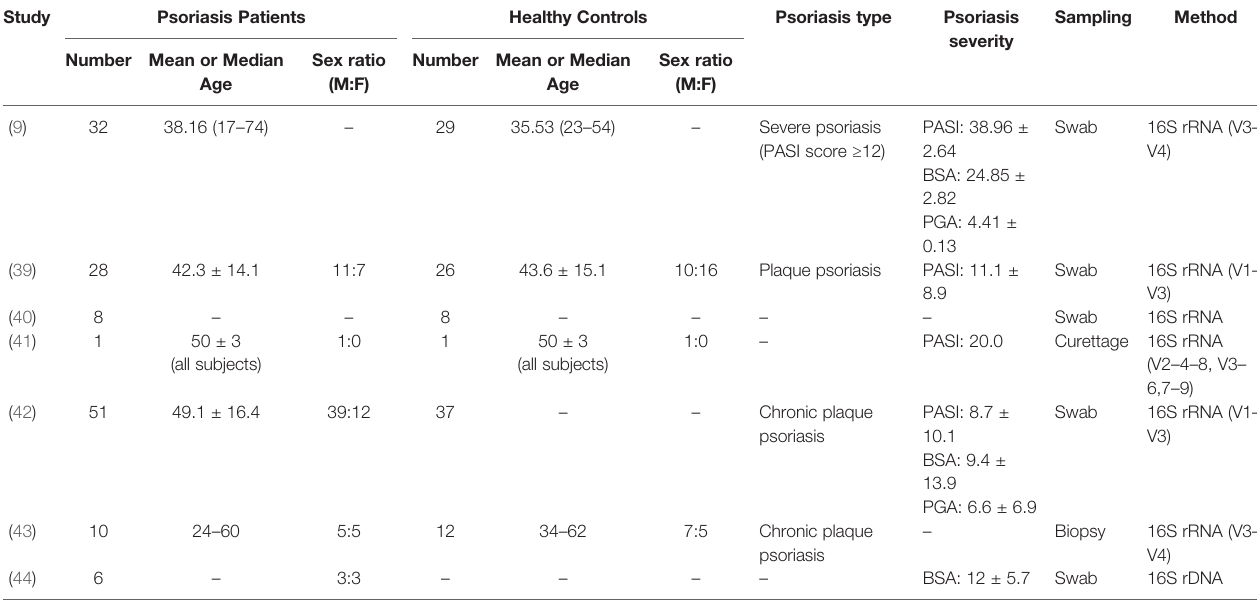
TABLE 1 | Summary of published clinical trials involving skin bacterial microbiota in psoriasis. Study Psoriasis Patients Healthy